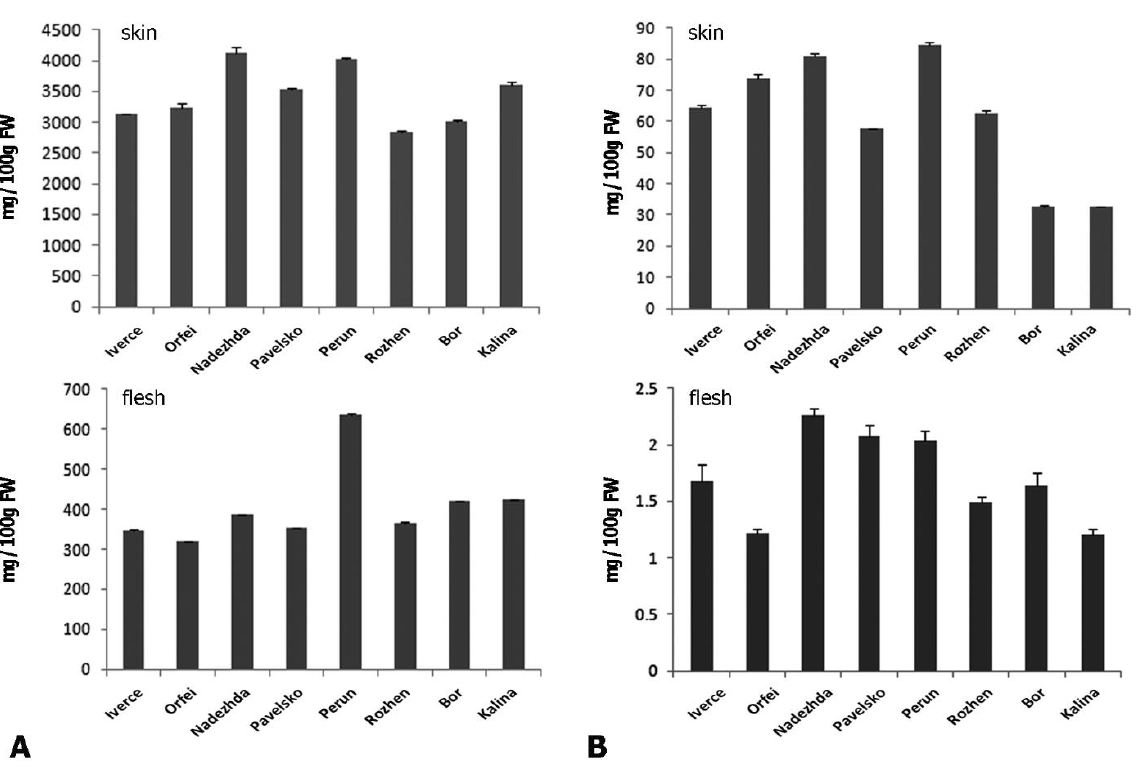
Figure 4. Concentration of total phenols and flavonoids in skin and flesh of potato cultivars. ( A ) Concentrations of total phenols. Upper panel represent total phenols measured in skin and lower panel phenols measured in flesh ( B ) Concentration of total flavonoids. Bars represent averaged means of three replicates and are given as mg per 100g of fresh weight of tubers Upper panel represent total flavonoids measured in skin and lower panel flavonoids measured in flesh.